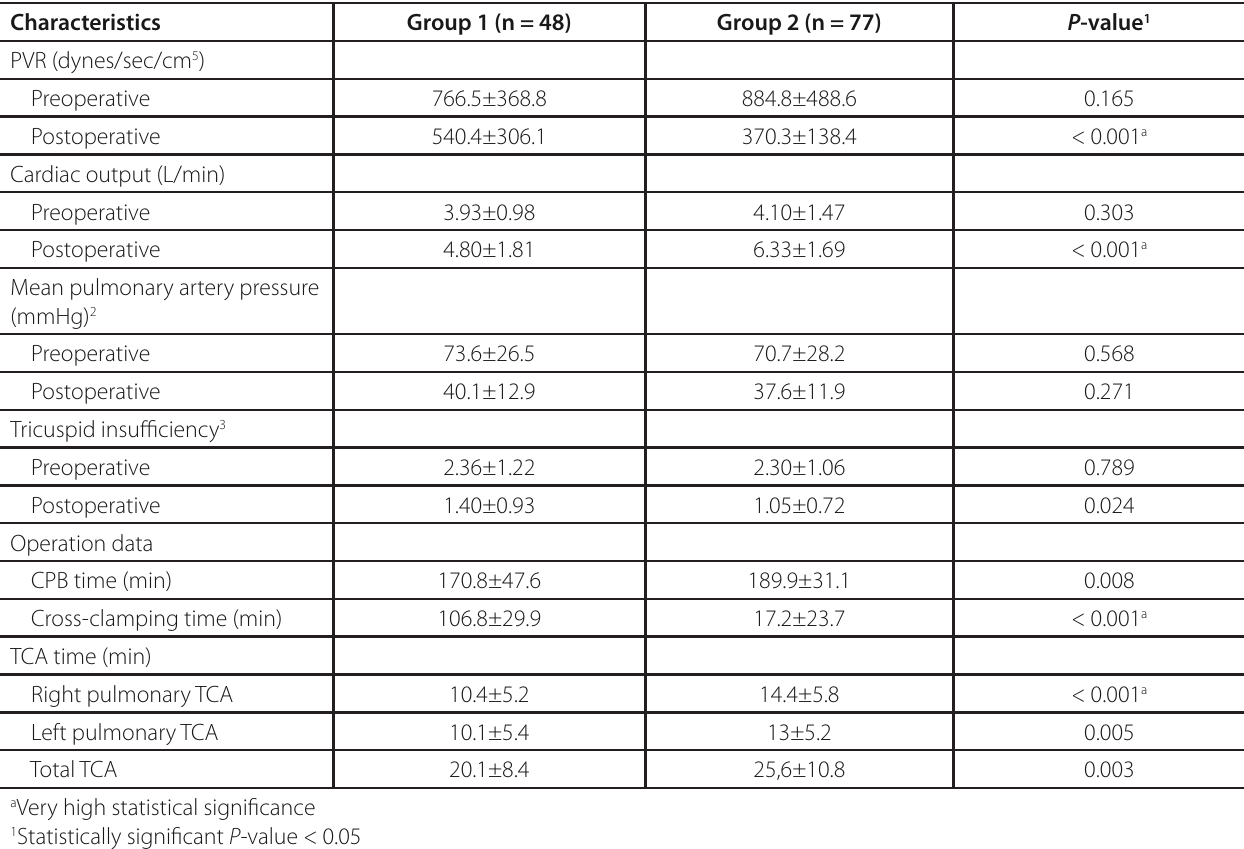
Table 4. Preoperative/postoperative hemodynamic results and operating room times.